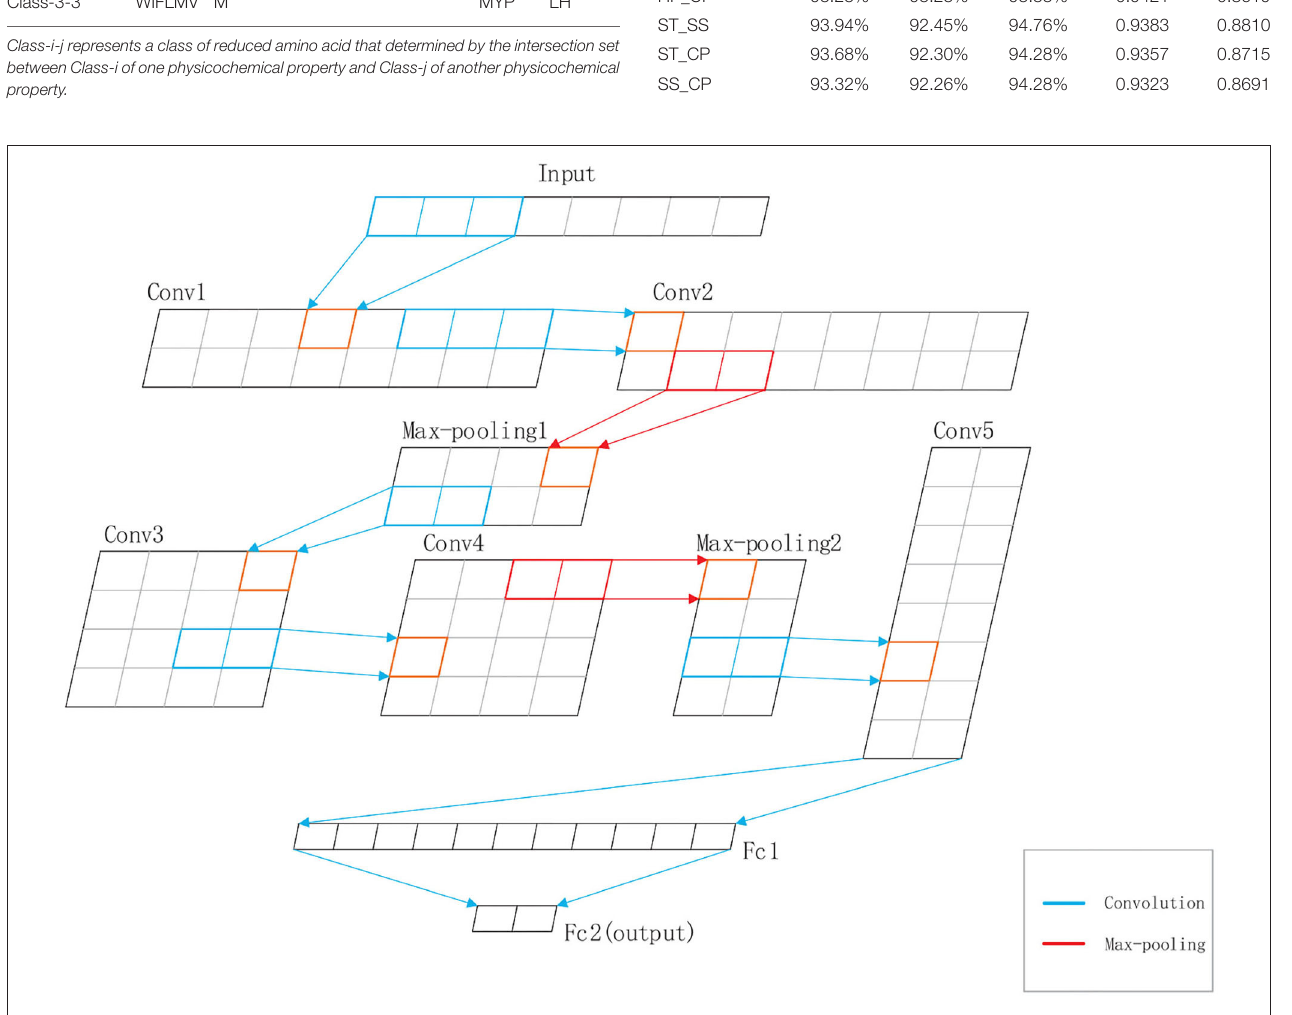
Frontiers in Cell and Developmental Biology |